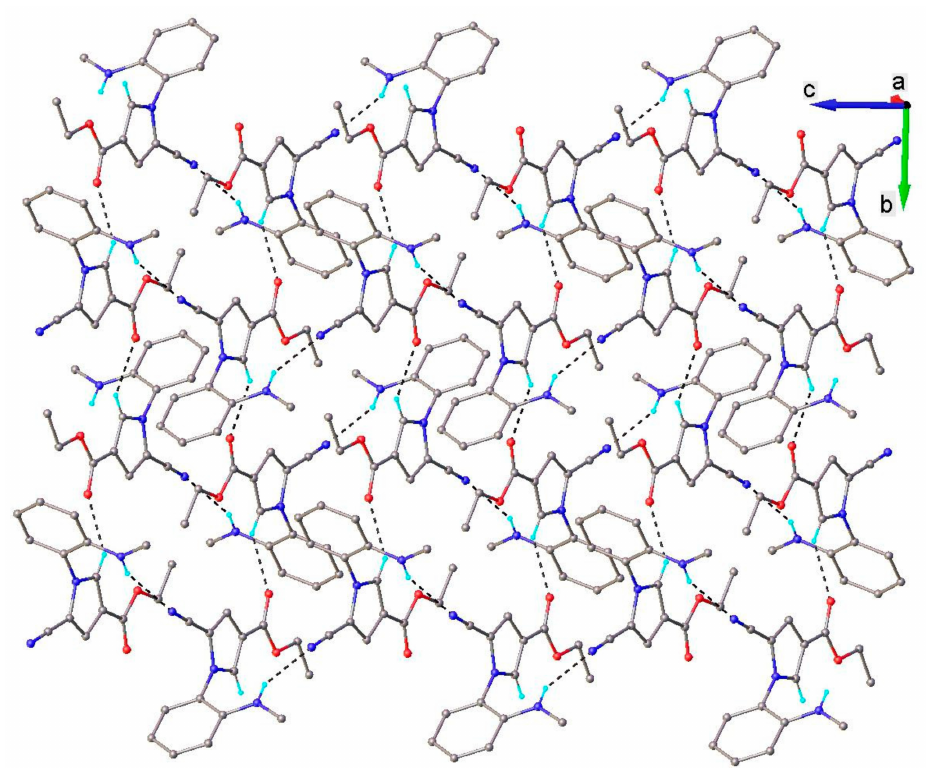
Figure 5. 2D-supramolecular network in the crystal structure 17c . Non-relevant are omitted. H- bonds parameters: N3-H ··· N2 [N3-H 0.88 Å, H ··· N2 2.30 Å, N3 ··· N2( x , 0.5– y , z –0.5) 3.075(2) Å, ∠ N3HN2 147.4 ◦ ]; C4-H ··· O2 [C4-H 0.95 Å, H ··· O2 2.36 Å, C4 ··· O2(1– x , 0.5 + y , 0.5– z ) 3.075(2) Å, ∠ C4HO2 143.7 ◦ ].